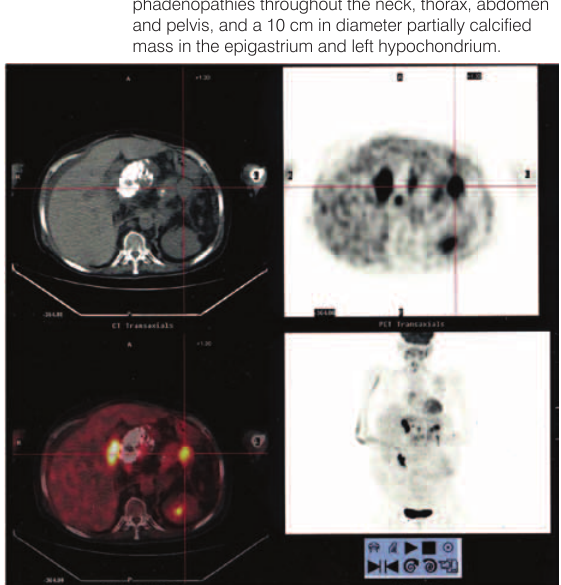
Figure 3. P ositron emission tomography/computed tomography with F18-fl uorodeoxyglucose revealing multiple lym- phadenopathies throughout the neck, thorax, abdomen and pelvis, and a 10 cm in diameter partially calcifi ed mass in the epigastrium and left